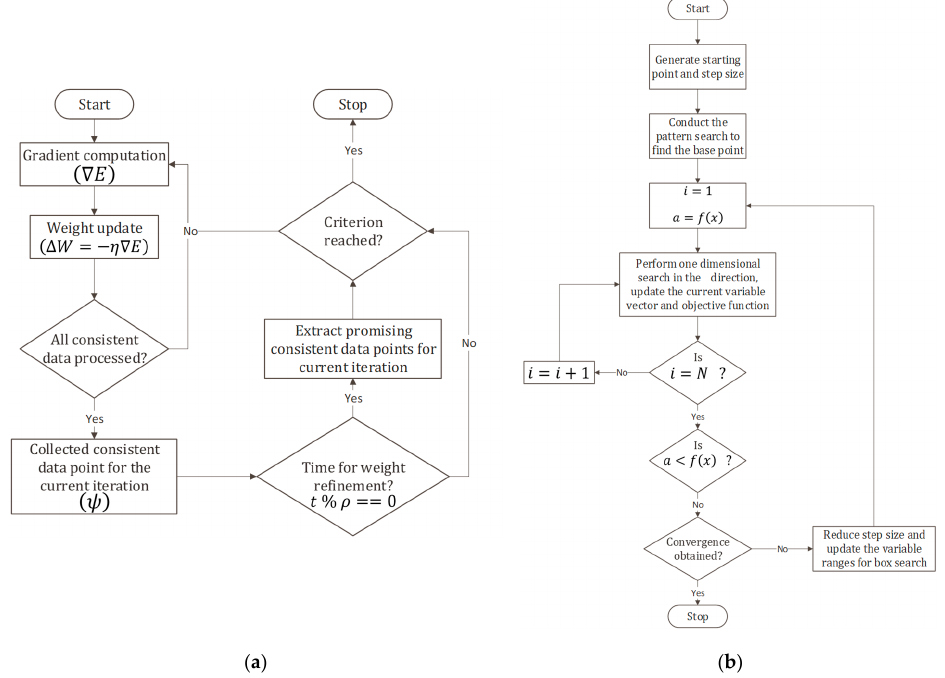
Figure 4. ( a ) Flowchart representation of the gradient descent optimization method [75] and ( b ) flowchart representation of the coordinate descent optimization algorithm